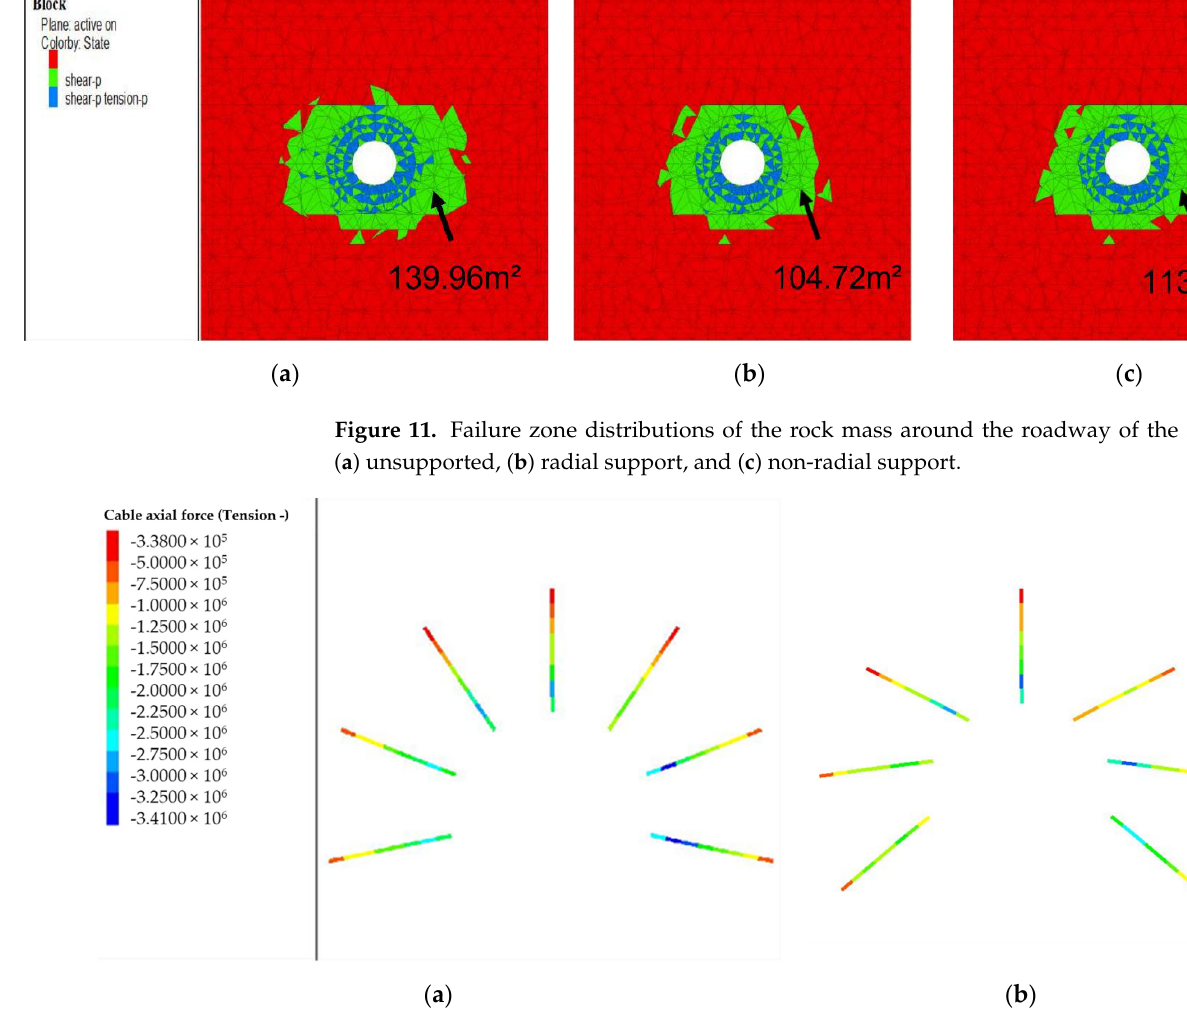
Figure 12. Bolt force distributions of the support face: ( a ) radial support and ( b ) non-radial